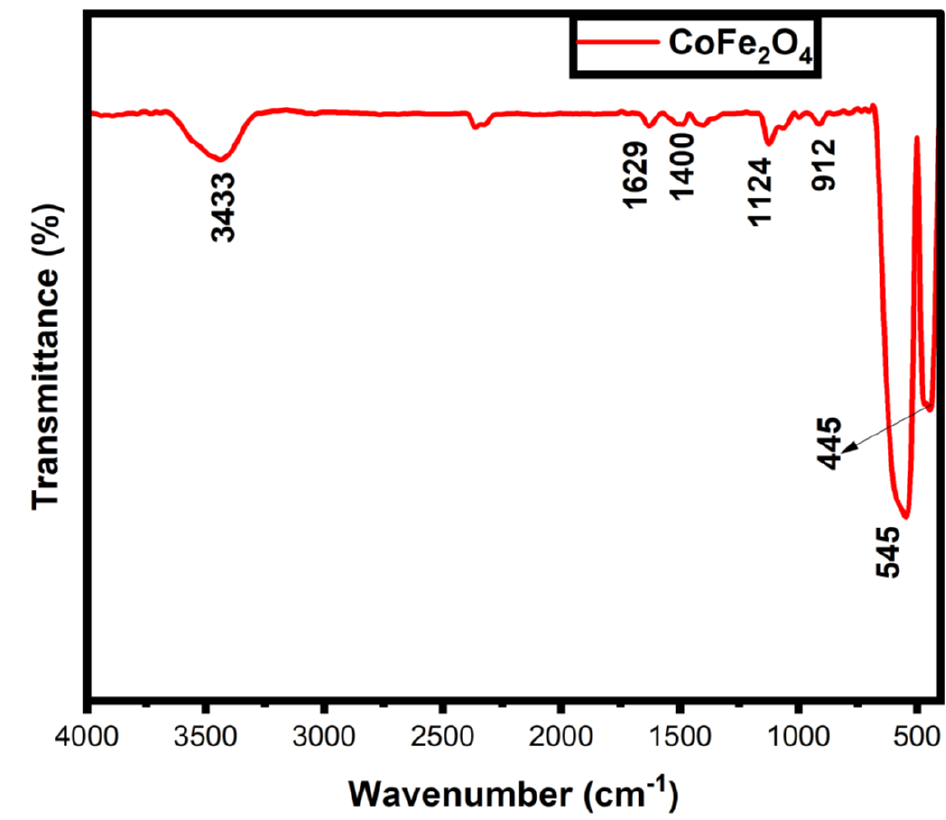
Figure 2. FTIR spectrum of biosynthesized CoFe 2 O 4 nanoparticles.